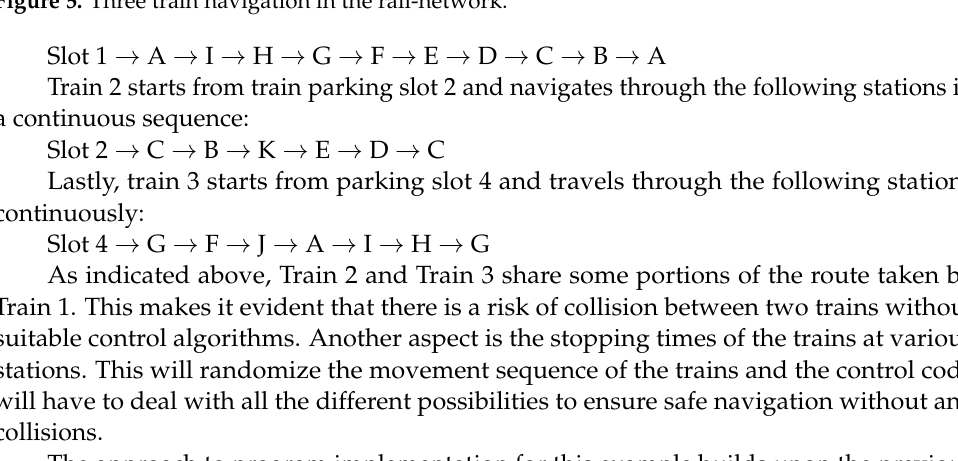
Figure 5. Three train navigation in the